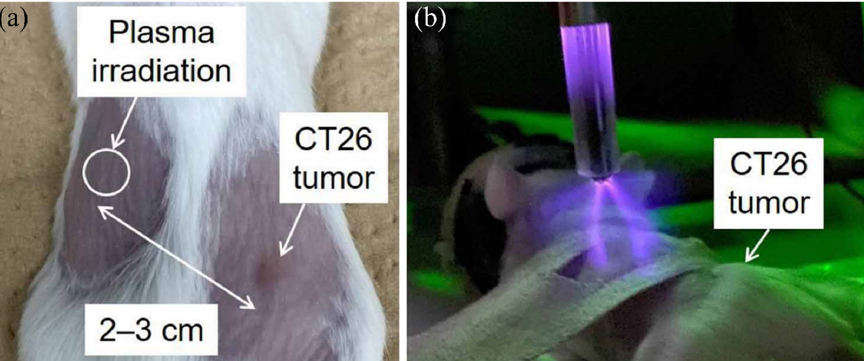
Figure 4. Anti-tumor abscopal effects in mice induced by a CAP treatment on normal tissue. ( a ) CAP irradiation site and murine colorectal carcinoma CT26 tumor on day 6. ( b ) CAP treatment on a normal tissue site can inhibit the nearby tumor’s growth [90].